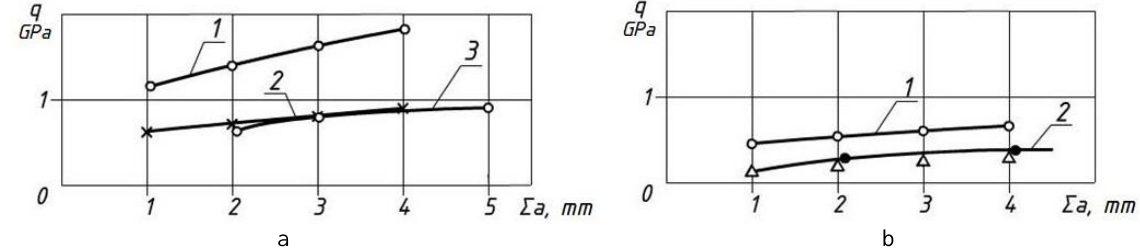
Fig. 10. The dependence of contact pressures on the total deformation during processing of billets: a) from steel 45: t 0 /d 0 =0,136, a 0 /d 0 =0,015: 1 – experiment, 2 – calculation according to (14), 3 – a 0 /d 0 =0,03 (experiment and calculation according to (14)); b) from steel 20: t 0 /d 0 =0,65, a 0 /d 0 =0,015: 1 – experiment, 2 – calculation according to (14) (∆); a 0 /d 0 =0,03 (●) – calculation according to (14) and